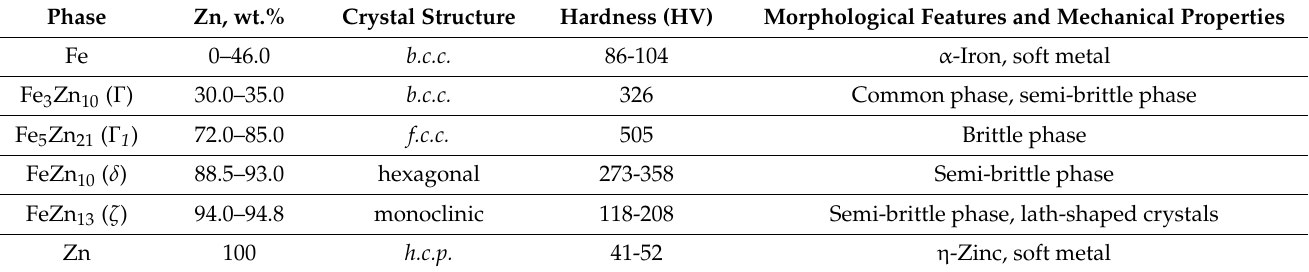
Table 5. Characteristics of different Fe x Zn y phases forming at room temperature [88,139]. Composition of Zn (in wt.%) varies depending on